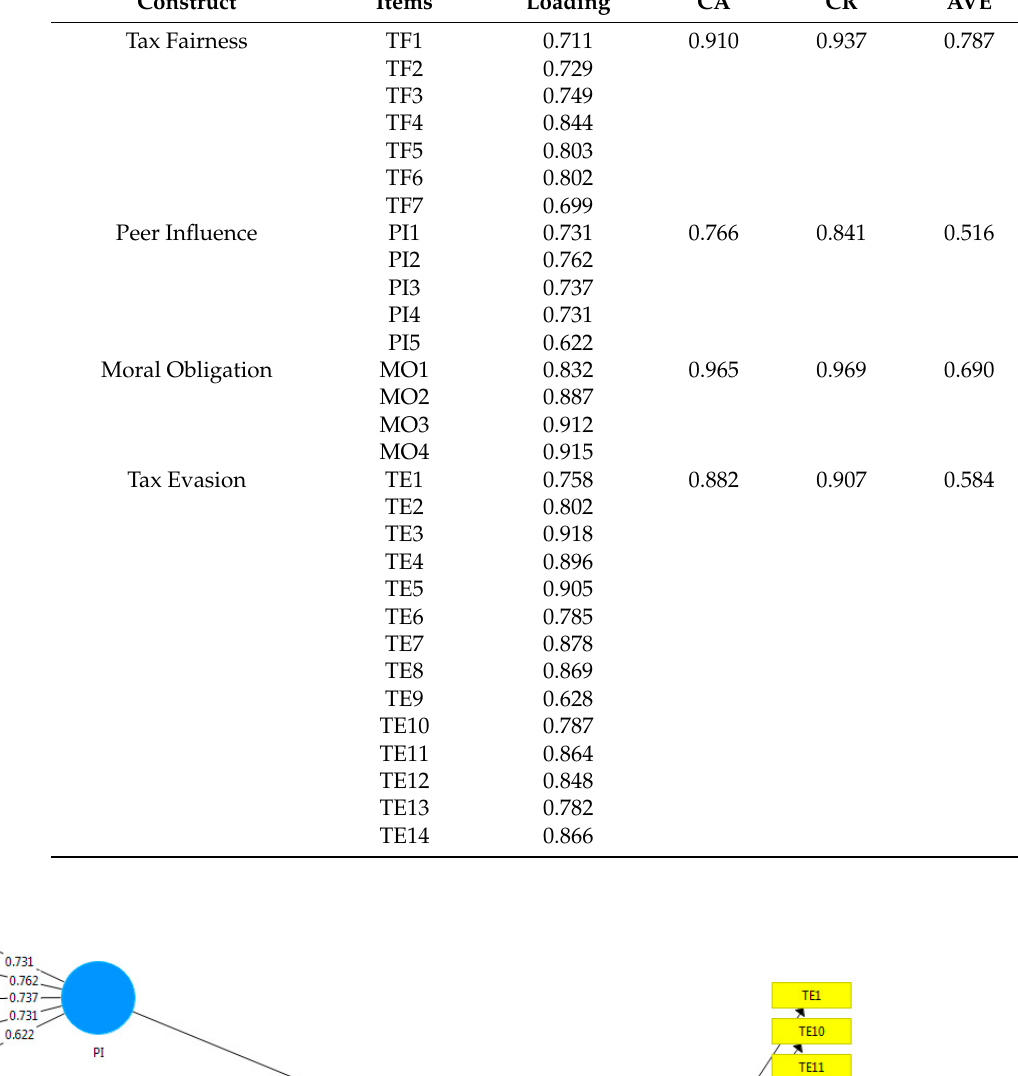
Table 1. Convergent validity for reflective measurement model of the constructs.